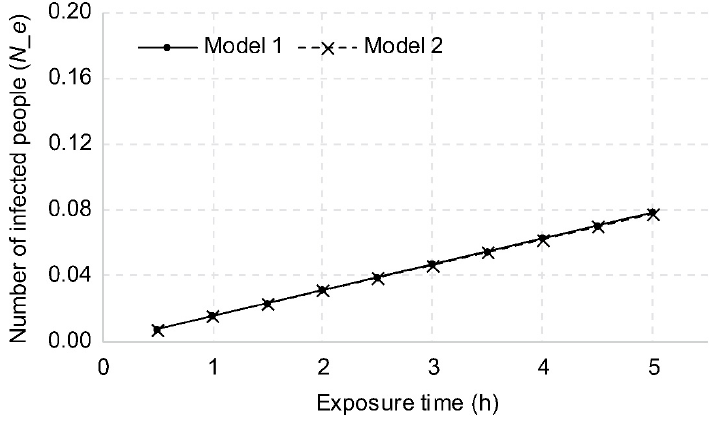
Figure 3. Changes in the number of new infections based on exposure time.